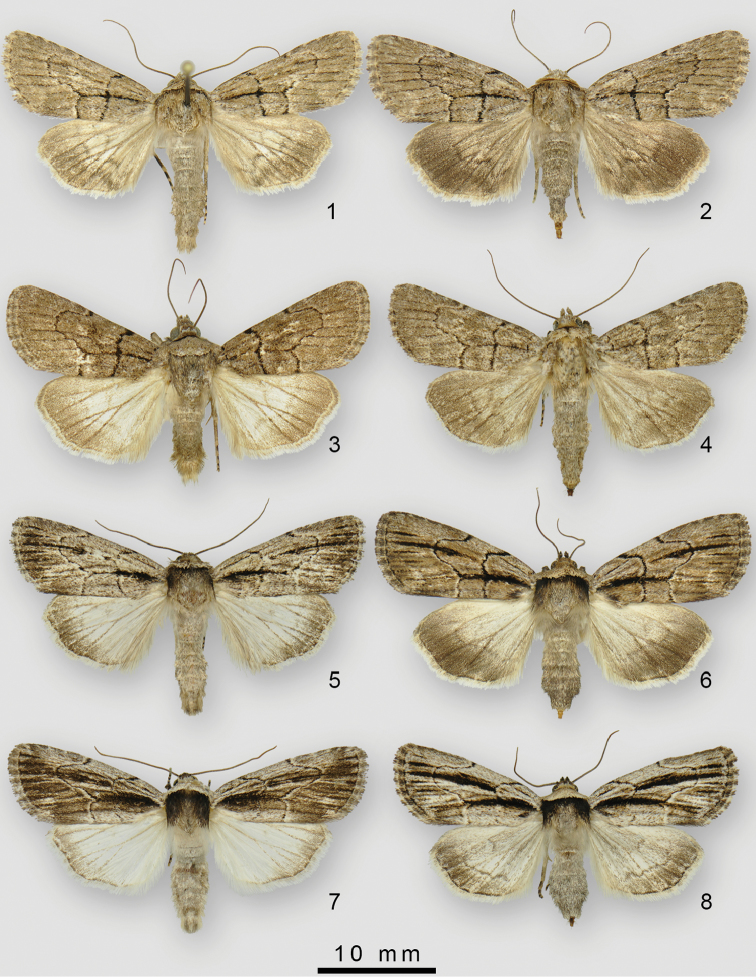
1Sympistiseleaner male (holotype) 2S.eleaner female (paratype) 3S.induta male 4S.induta female 5S.tenuistriga male 6S.tenuistriga female 7S.badistriga male 8S.badistriga female.